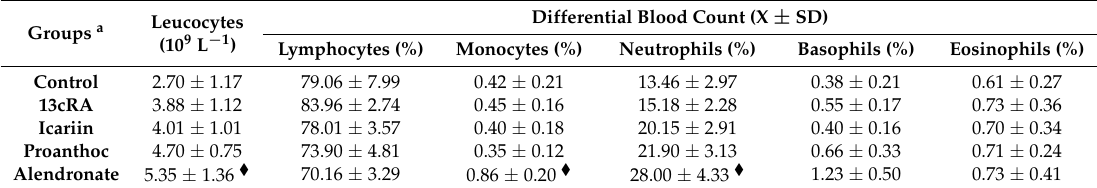
Table 2. Effect of icariin, proanthocyanidins and alendronate on leukocytes number and differential blood count in rats with retinoic acid-induced bone